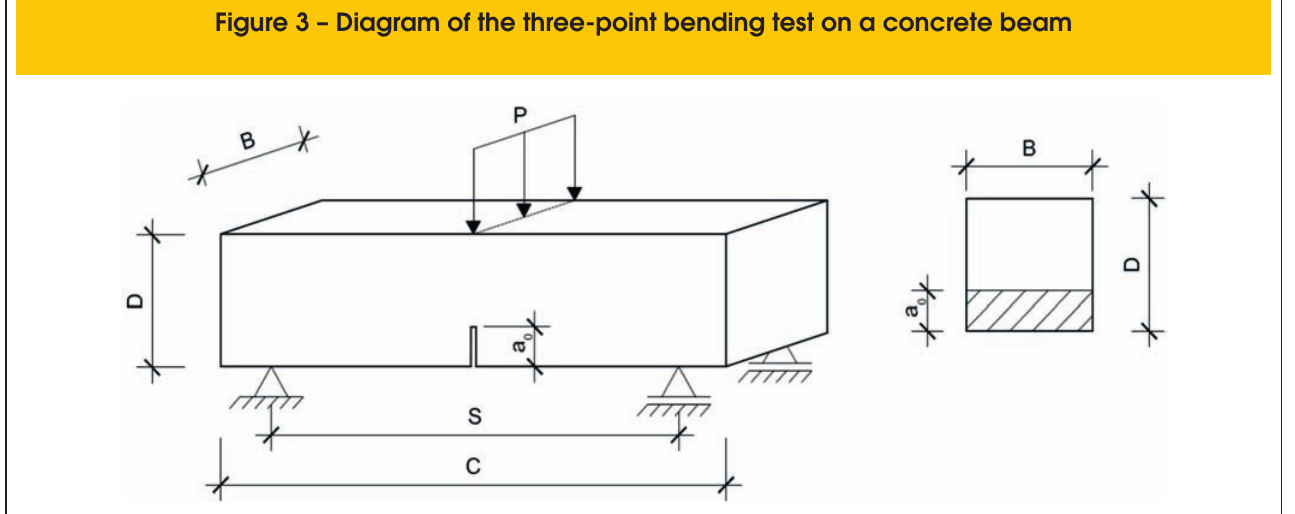
Figure 3 – Diagram of the three-point bending test on a concrete